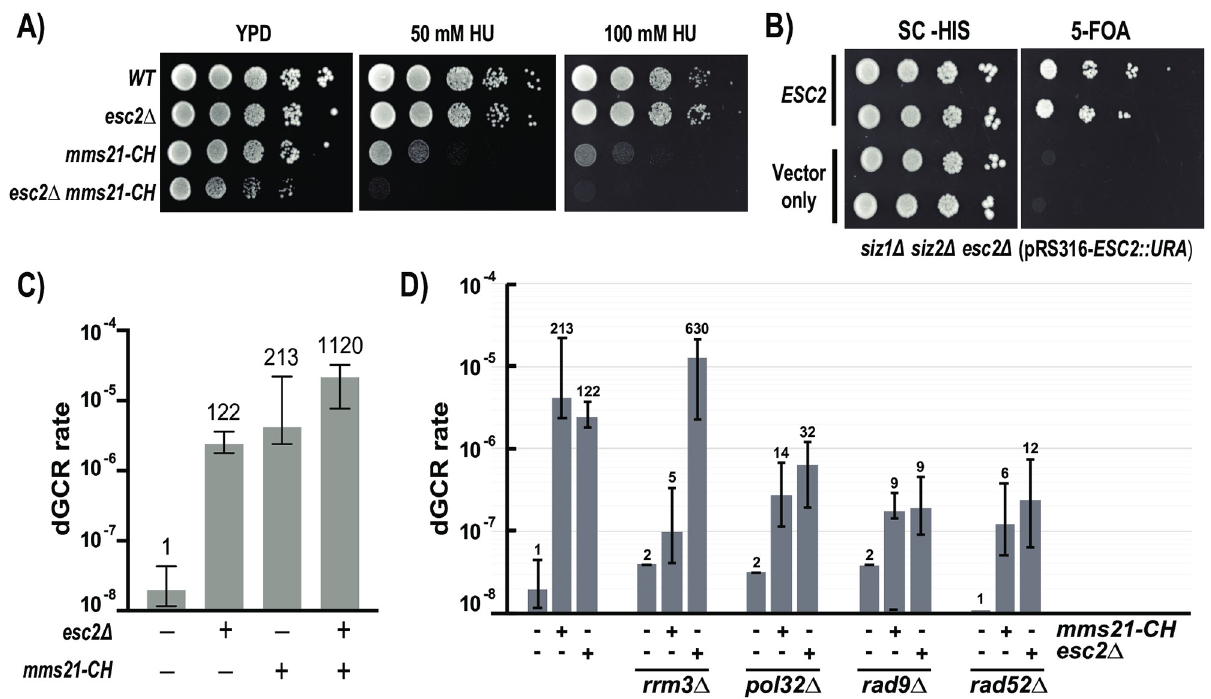
Fig 1. Esc2 and Mms21 have distinct and shared roles in maintaining cell growth and suppressing dGCRs. A) Spot assays to measure hydroxyurea (HU) sensitivity (50 mM and 100 mM) of WT, esc2 Δ , mms21-CH and mms21-CH esc2 Δ mutants. The YPD plate is shown to show cell growth in the absence of drug. B) 5-FOA plasmid shuffling of a URA3 plasmid expressing ESC2 demonstrates the effect of evicting Esc2 in the siz1 Δ siz2 Δ esc2 Δ triple mutant. C) dGCR rates of WT, esc2 Δ , mms21-CH and esc2 Δ mms21-CH mutants, measured via fluctuation analysis. D) dGCR fluctuation analysis demonstrating the effect of combining esc2 Δ with rad52 Δ , pol32 Δ , rrm3 Δ and rad9 Δ . Error bars represent the upper and lower bounds of the 95% confidence interval with fold changes relative to WT shown above each respective analysis. For reference, mms21-CH specific data were taken from our previous